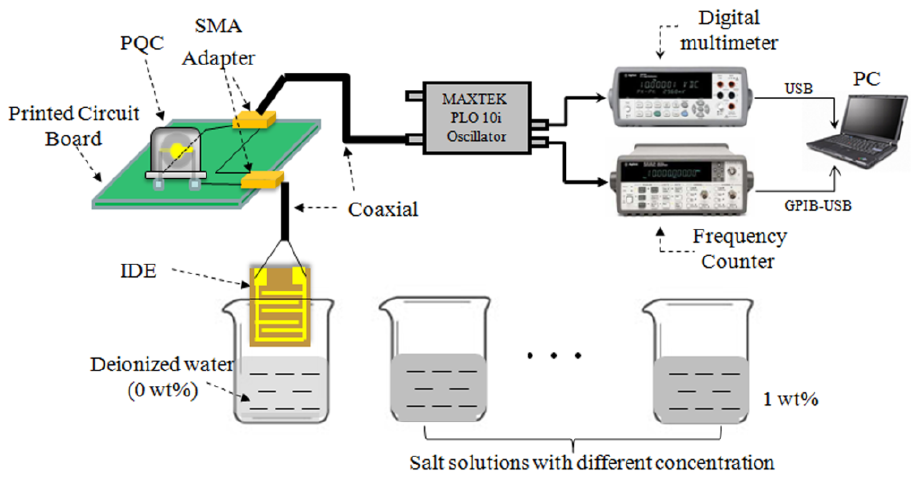
Figure 1. Schematic diagram of the experimental setup.